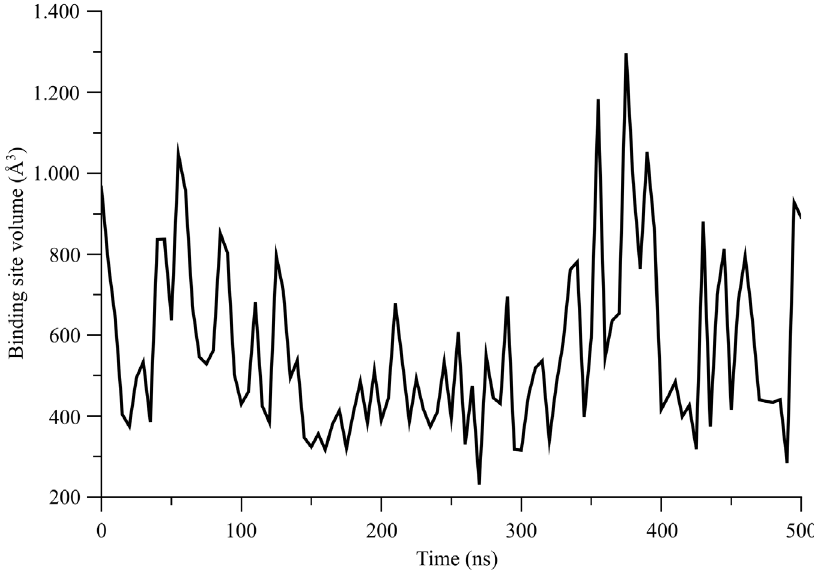
Fig. 6. POCASA binding site volume measured every 5 ns of the 0.5 m s all-atom MD simulation of the m OR structure.